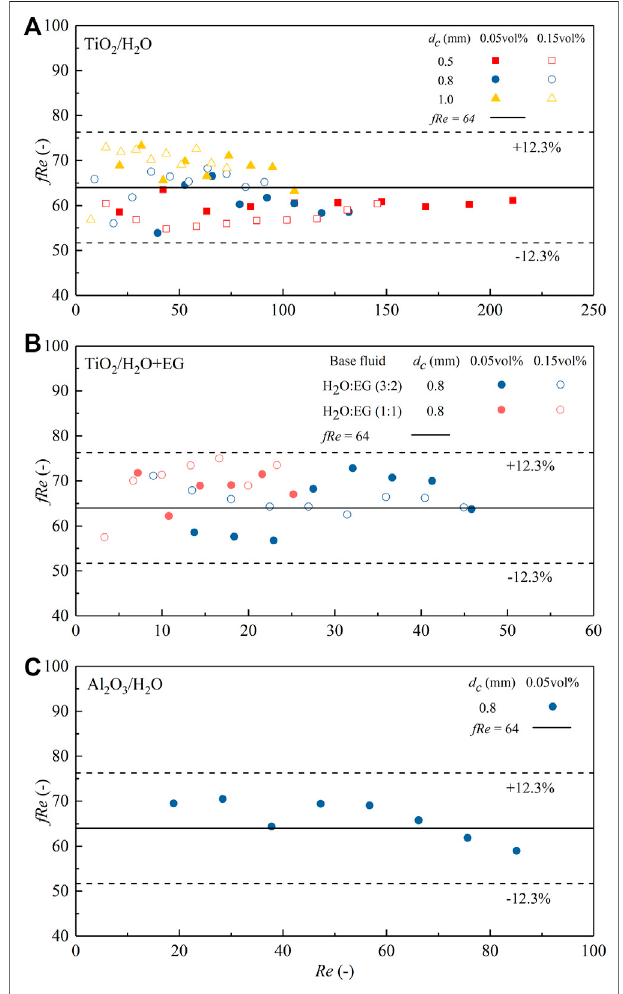
FIGURE 9 | Comparison between the measured fRe under TiO 2 or Al 2 O 3 -based nano fl uid single-phase fl ow in the microchannel and the theoretical value. (A) TiO 2 /H 2 O; (B) TiO 2 /H 2 O + EG; (C) Al 2 O 3 /H 2 O. Symbols represent the experimental data and solid lines the theoretical